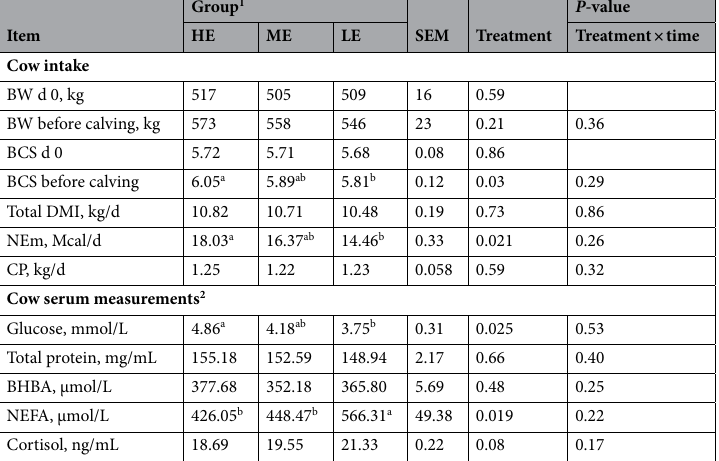
Table 2. Precalving intake and plasma measurements of late gestating beef cows offered isonitrogenous, total- mixed diets formulated to provide 110 (HE), 100 (ME) or 90% (LE) of daily NEm requirements during the last 45 d of gestation. 1 HE = high energy (NEm = 1.67 Mcal/kg of DM); ME = medium energy; (NEm = 1.53 Mcal/ kg of DM); LE = low energy (NEm = 1.39 Mcal/kg of DM). 2 Overall plasma concentrations of glucose, total protein, BHBA, NEFA, and cortisol collected on d 0, 24, 31, and 38. a,b ,c Means bearing different superscripts in the same row difer significantly (P <